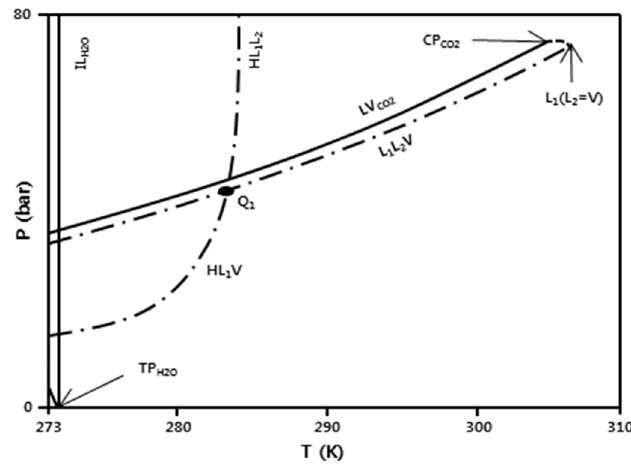
Figure 2. Schematic of spray test condition mapping in P–T diagram of CO 2 -water mixture [12].